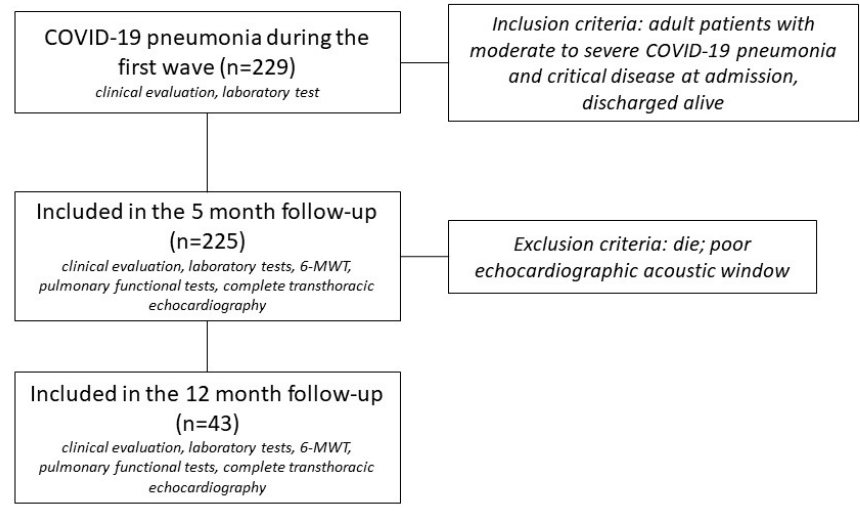
Figure 1. Study design.